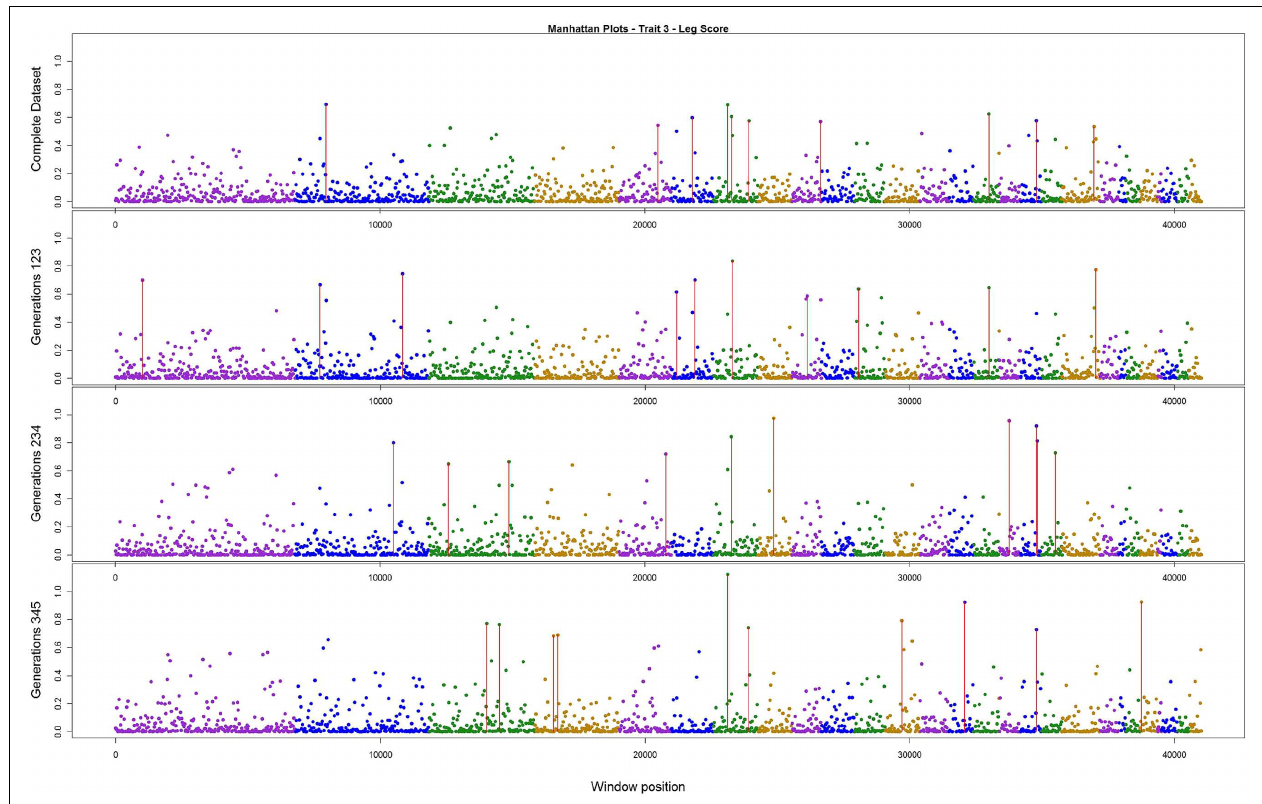
FIGURE 4 | Manhattan plots for percentage of variance explained for Leg score, performed for all the data set, and the subsets of generations.